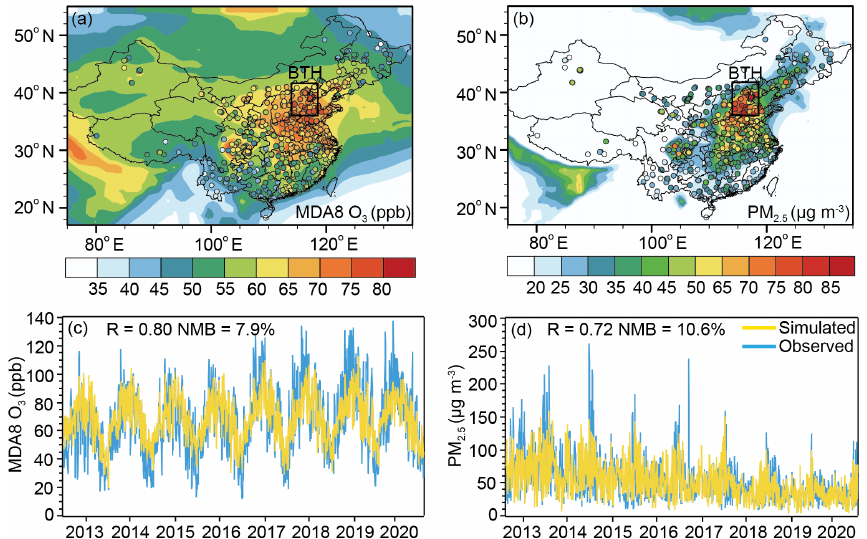
Figure 3. Spatial distributions of simulated (shades) and observed (CNEMC, dots) surface-layer concentrations of (a) MDA8 O 3 (ppb) and (b) PM 2 . 5 (µgm − 3 ) averaged over the eight warm seasons (April to October, 2013–2020). The solid black rectangle in (a) and (b) indicates the BTH region. Simulated and observed daily concentrations of surface-layer (c) MDA8 O 3 and (d) PM 2 . 5 averaged over BTH. The correlation coefficient ( R ) and normalized mean bias (NMB) are also shown for (c) and (d) . NMB